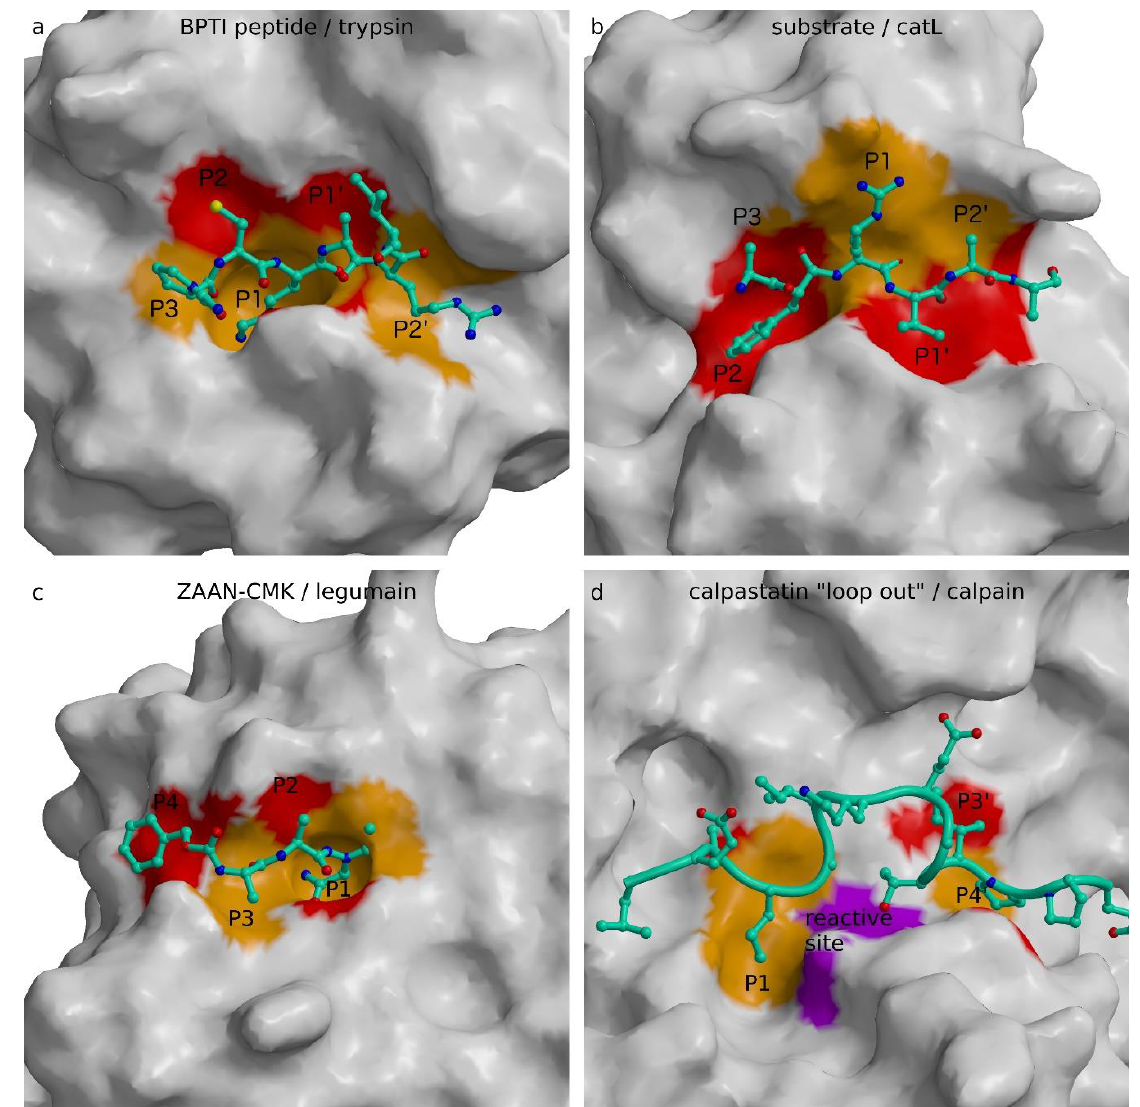
Figure 4. Substrate and substrate-like binding. Peptidyl substrates with their positions marked are shown as ball (nitrogen: blue, oxygens: red, carbons: cyan) and stick (cyan) models on the background of the protease surface. The surface is white with the exception of the substrate binding sites S3, S1, and S2 (cid:48) , respectively corresponding to substrate positions P3, P1, and P2 (cid:48) colored orange, and S4, S2, and S1 (cid:48) respectively corresponding to substrate positions P4, P2, and P1 (cid:48) colored red. The figure was prepared using MAIN [35] and rendered with Raster3d [36]. ( a ) Canonical conformation of BPTI peptide bound to trypsin ([24], PDB code 2TGP). BPTI peptide is shown as a ball and stick model on the background of trypsin structure shown in white, with the exception of the substrate-binding sites surface from S3 to S3 (cid:48) colored alternatively red and orange. ( b ) Substrate model bound to cathepsin L. The cathepsin L model was used from a previous study [11]. ( c ) Peptidyl inhibitor bound to legumain ([170], PDB code 4AWB). Z-Ala-Ala-Asn (ZAAN) binds to the non-prime region of the active site cleft. ( d ) Calpastatin loop out region bound to calpain-m ([99], PDB code 3DF0). The 172–185 region of calpastatin is shown as a coil for the main chain trace, and a ball and stick model for side chains on the background of the protease surface. The calpain surface was generated with the residues from S241 to V253, I260, and Q261 excluded to enable the view in the active site cleft. The surface of the reactive site residues C105S and H262 is